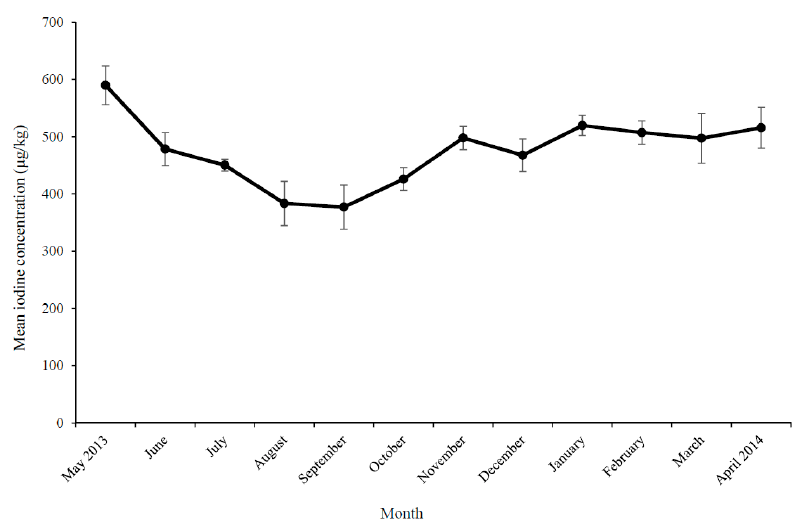
Figure 1. (Mean ± standard deviation (SD)) Iodine concentration of Northern Ireland (NI) milk (combined skimmed, semi-skimmed and whole) according to month of collection.